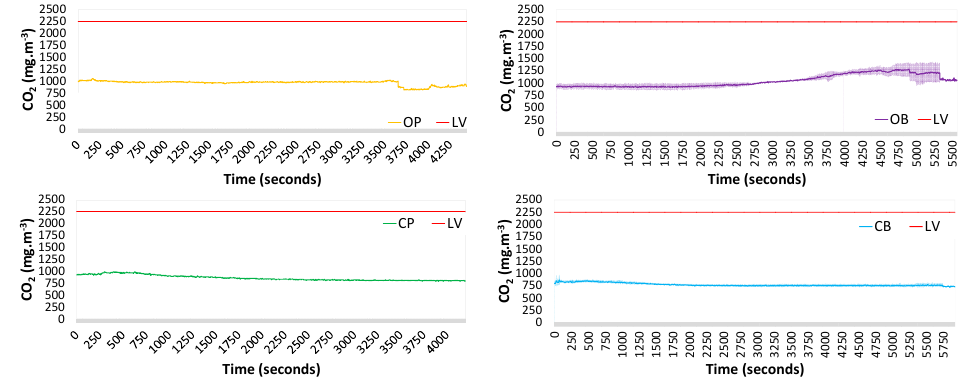
Figure 6. Temporal variability of CO 2 (line—mean; light colored area—standard deviation) during the combustion period for the four studied conditions: ( top , left ) OP—open fireplace and pinewood, ( top , right ) OB—open fireplace and briquettes, ( bottom , left ) CP—closed fireplace (insert) and pinewood, and ( bottom , right ) CB—closed fireplace (insert) and briquettes. Red line represents the CO 2 limit value of 2250 mg·m − 3 defined by the Portuguese legislation [32].